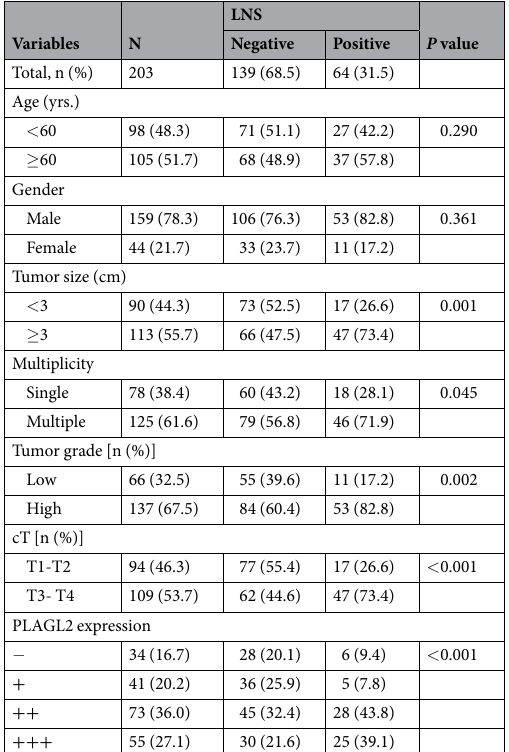
Table 4. Association of clinicopathological features with lymph node metastasis of bladder urothelial carcinoma.